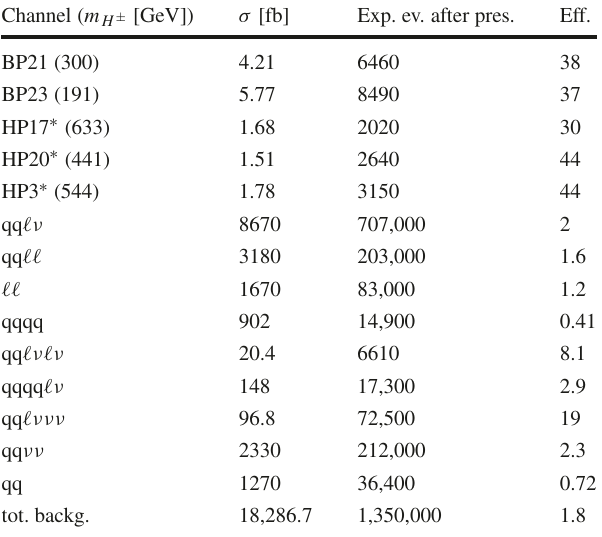
Table 4 Results of the preselection at √ s 3TeV CLIC running stage = for the benchmark points and background channels considered in the full simulation study. Shown are cross sections σ , numbers of events expected after preselection cuts for an integrated luminosity of 4ab − 1 and the preselection efficiency. For signal scenarios, the mass scale of the charged IDM scalar is indicated in parenthesis, for other model parameters see Table 1. Scenarios with off-shell W ± production are marked with a